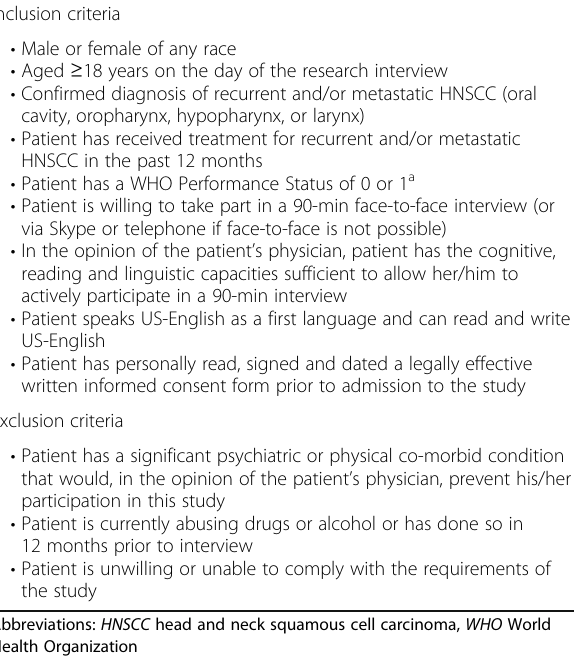
Table 1 Eligibility criteria for research